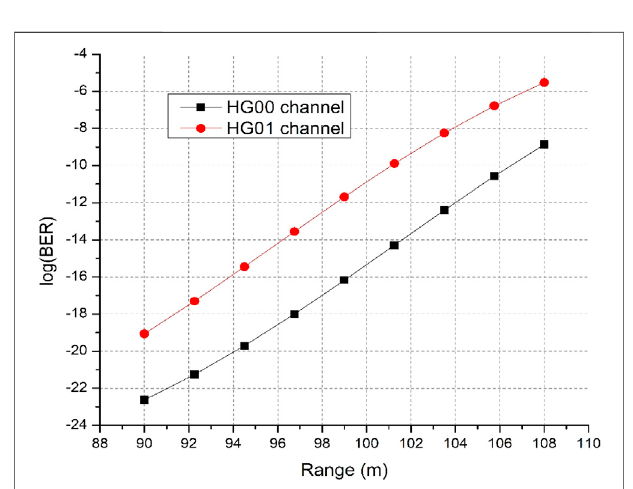
FIGURE 11 | log (BER) v/s transmission distance for dense dust.